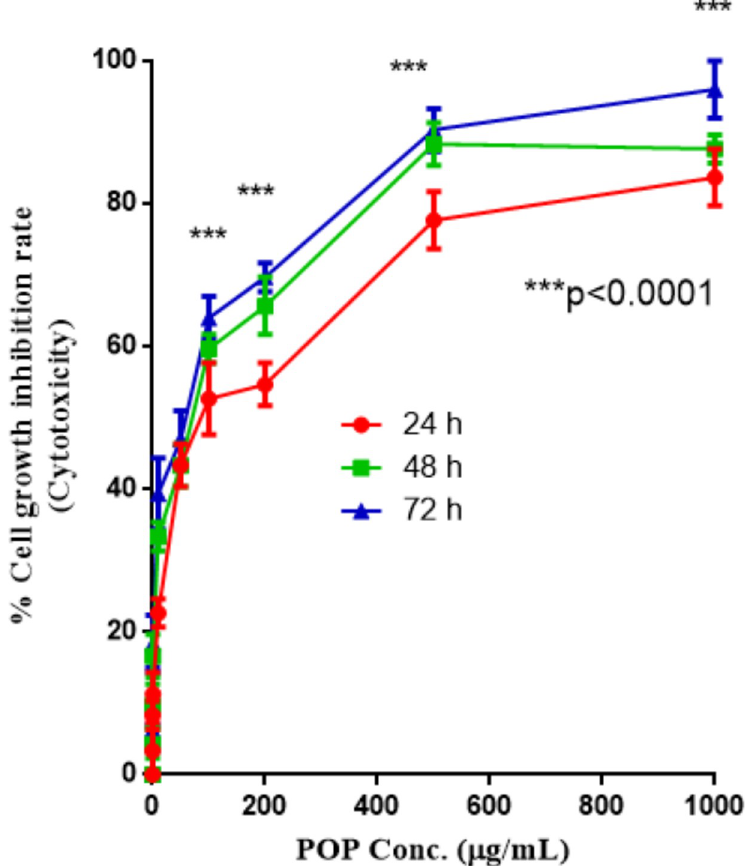
Fig 8. Cytotoxicity of purified POP on murine lymphoid cancer cell line (EAC cell line). POP, Pleurotus ostreatus